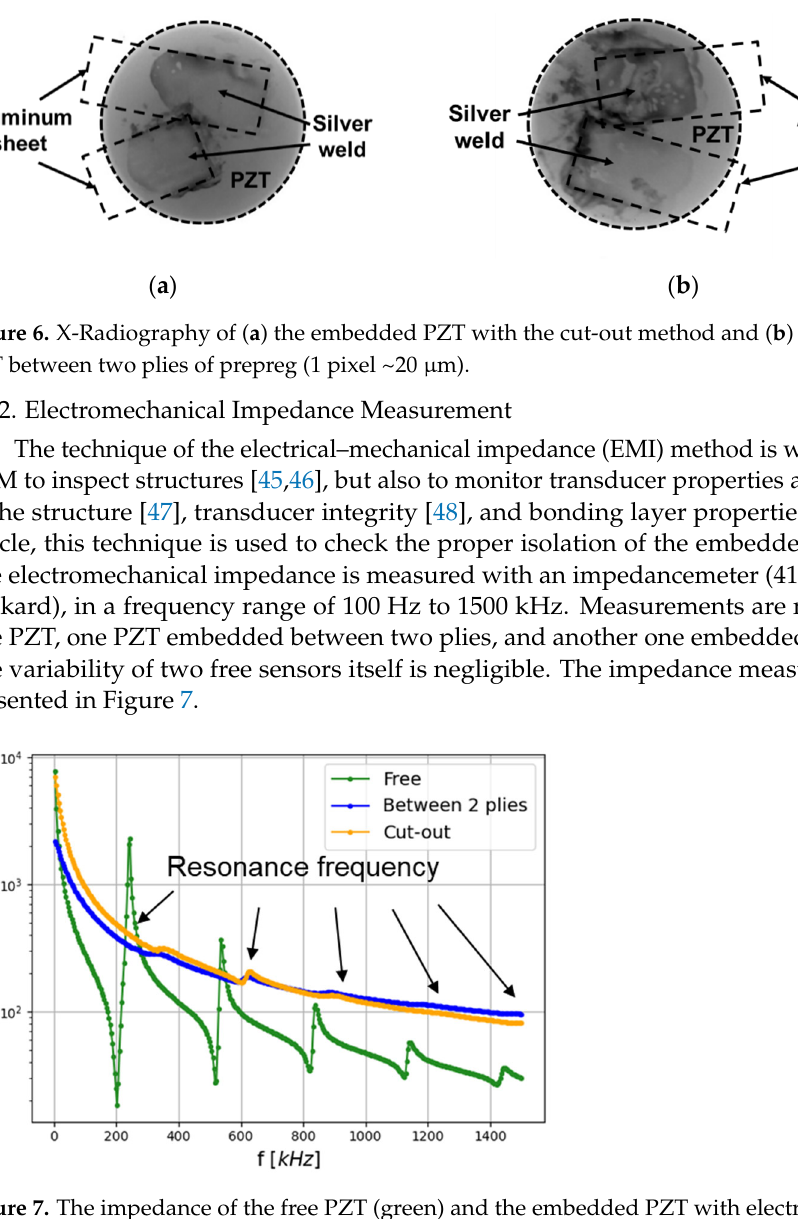
(1) where R burst is the FFT of the registered signal if the emission is a burst, R chirp is the FFT of the recorded signal after the transmission of a chirp, S burst is the generated burst signal, and S chirp is the generated chirp signal. Figure 9 displays an example of the module-nor- malized FFT, but the post-processing is based on the non-normalized FFT. The R_burst is the FFT of the signal registered if the emission was a burst and depends on the S_burst